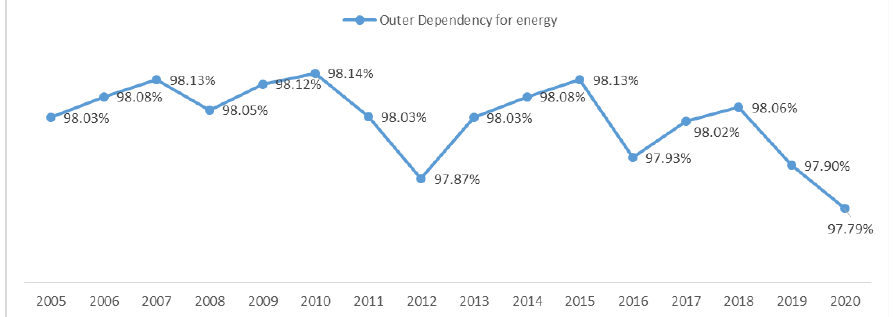
Figure 4. Taiwan’s energy dependency (2005–2020). Source: Bureau of Energy, MOEA. Table 1. Domestic and imported energy in Taiwan.